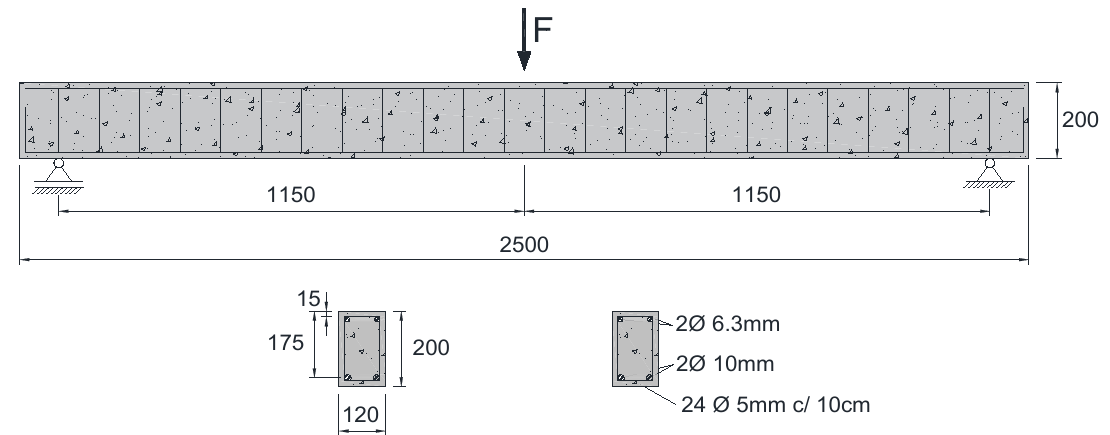
Figure 5. Characteristic of reinforced concrete beams (units in mm).